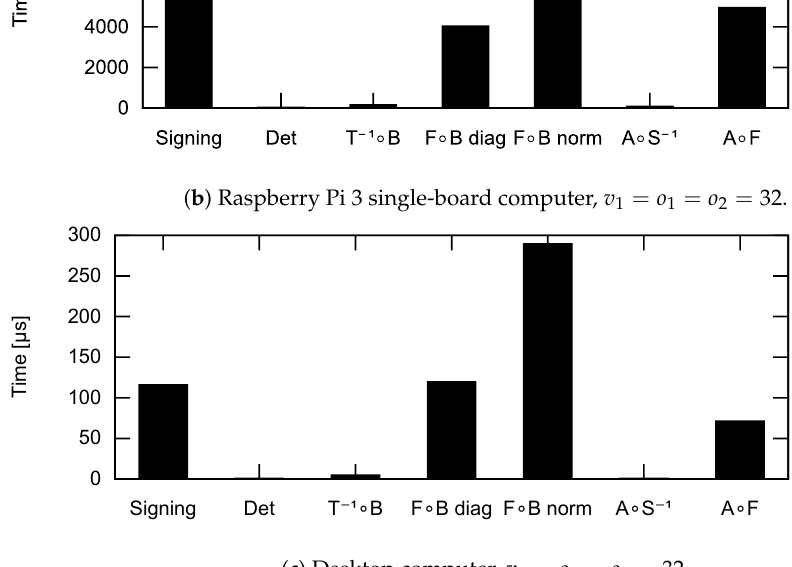
Figure 2. Execution times of the components in equivalent key